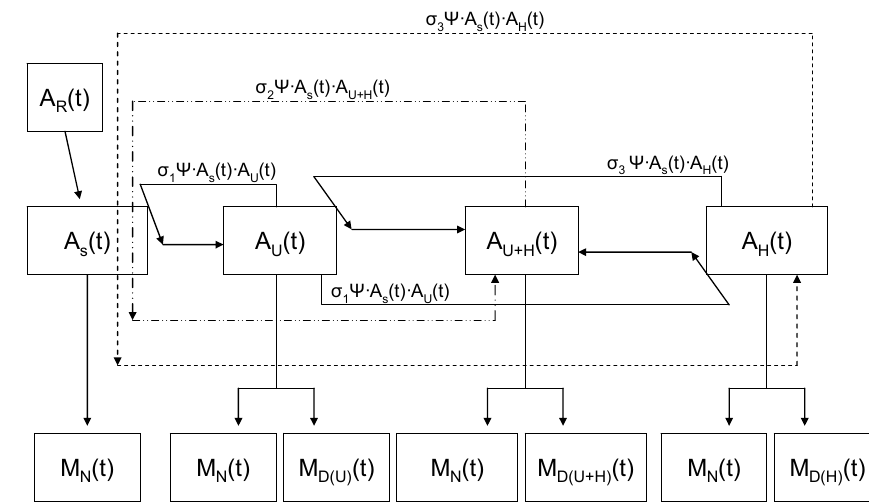
Figure 8. Illustration of the complex transmission dynamics of the ranavirus, when both of the observed disease syndromes are present in the population. Dashed lines are used to make the disease syndrome-specific vectors of the transmission easier to follow. The box sizes are not representative of the number of individuals in each category. The order of the boxes does not indicate when the given disease syndrome was introduced. All parameters have time components associated with them. A s is the number of susceptible individuals, Ψ is the contact rate, σ is the likelihood of transmission, M N is the natural mortality rate, and M D is the mortality rate associated with ranavirosis.